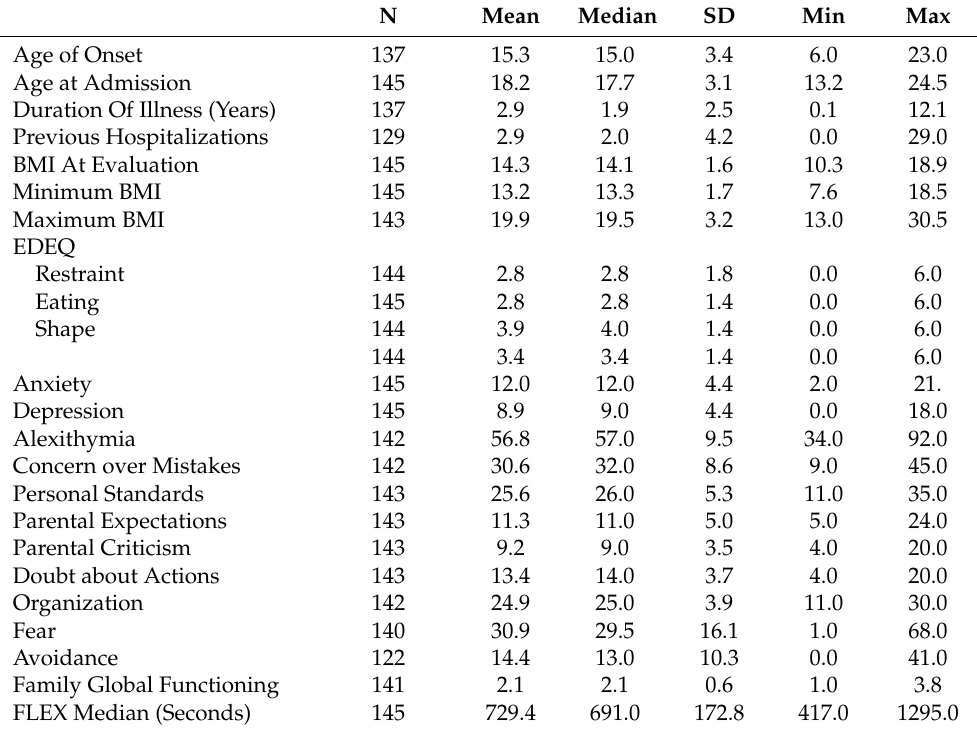
Table 1. Descriptive statistics.